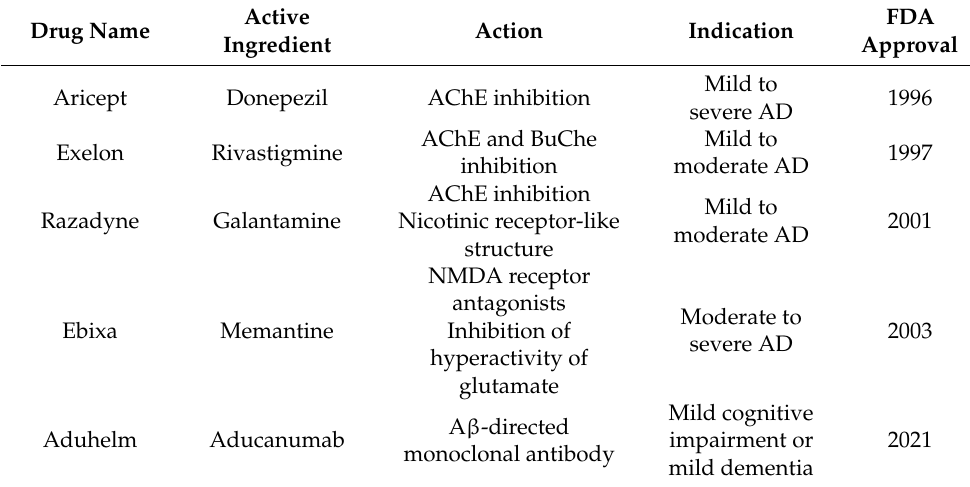
Table 1. FDA-approved drugs for